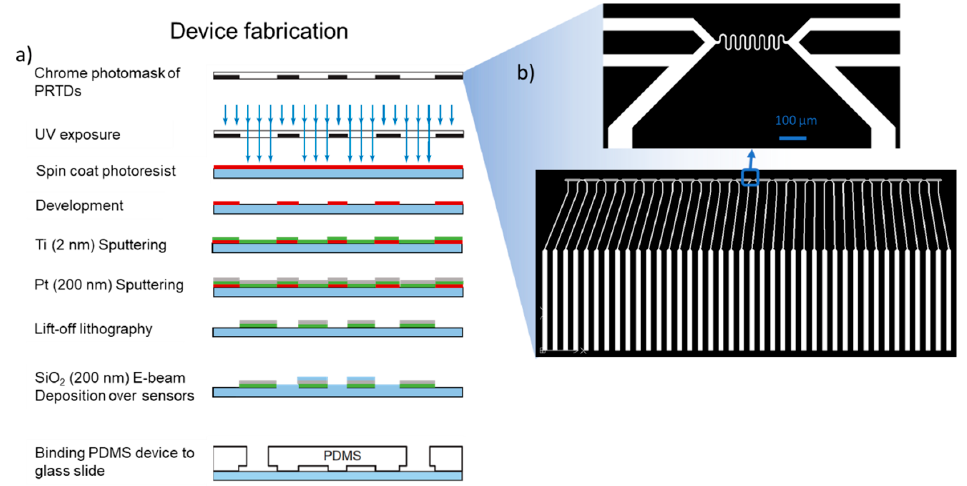
Figure 3. PRTD array fabrication and integration with microfluidic poly-dimethylsiloxane (PDMS) channels. The design is based on Stan et al. [48]. ( a ) PRTD array fabrication and bonding process schematic; ( b ) Array mask design, showing 19 PRTD arrays in a row.